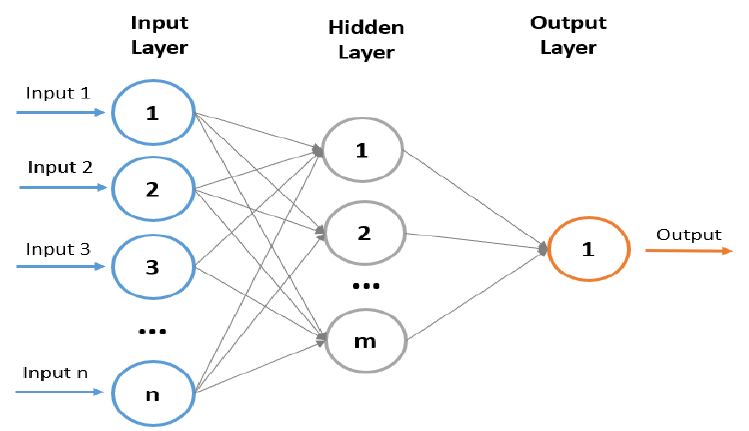
Figure 6. Source: Multilayer neural network diagram. Own elaboration.